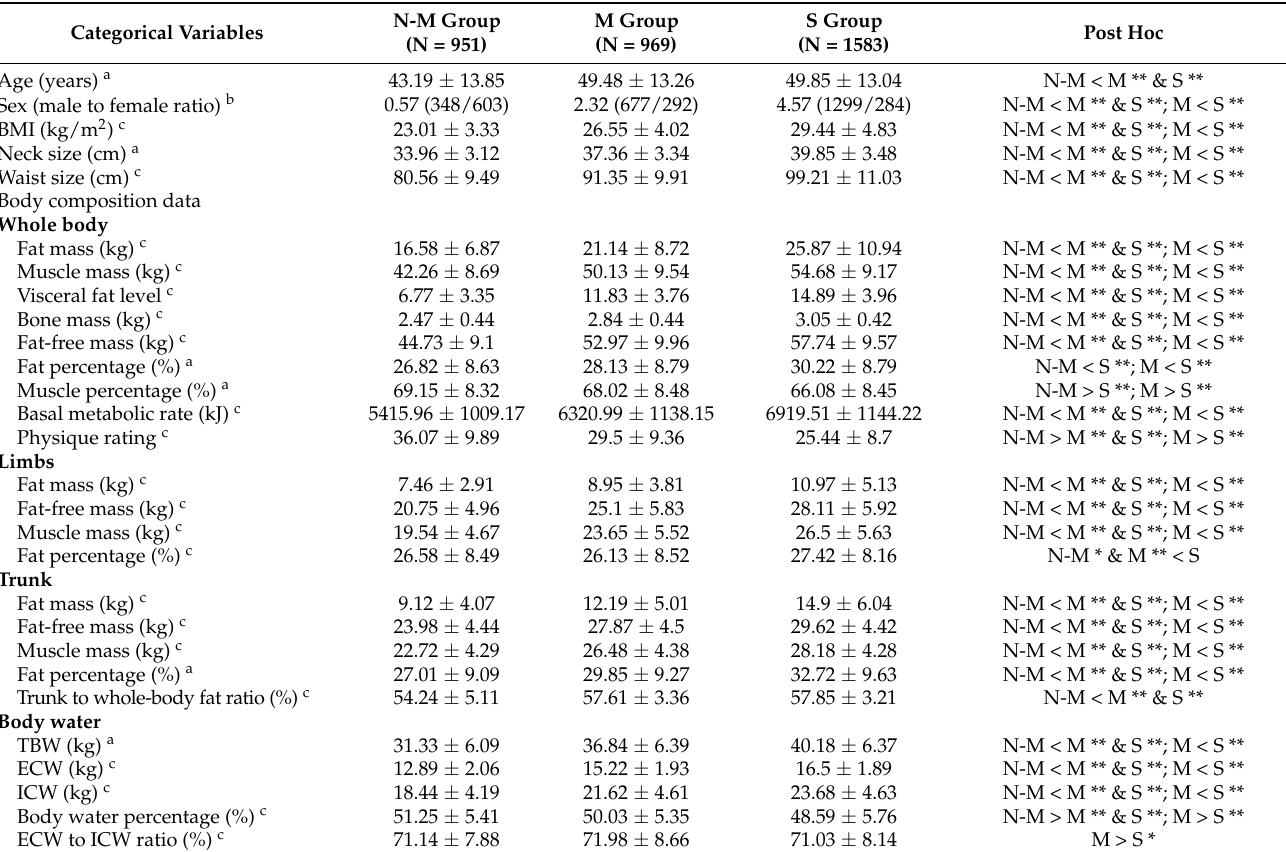
Table 1. Baseline characteristics and body composition parameters of participants grouped by OSA